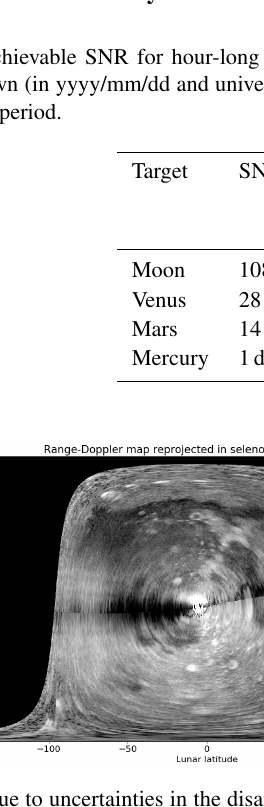
Figure 4. A comparison of interhemispheric cross talk (Eq. 2) be- tween the configuration used by Vierinen et al. (2017b), using the Jicamarca radio observatory, and the EISCAT 3D facility and ev- ery unique interferometric baseline larger than 50m. The apparent lunar latitude is terminated at approximately 0.05 ◦ . Note that the es- timate for EISCAT 3D is lower, at all points, than what is estimated for Jicamarca, which suggests that even regions close to the Doppler equator should be possible to disambiguate with the interferometric capabilities of EISCAT